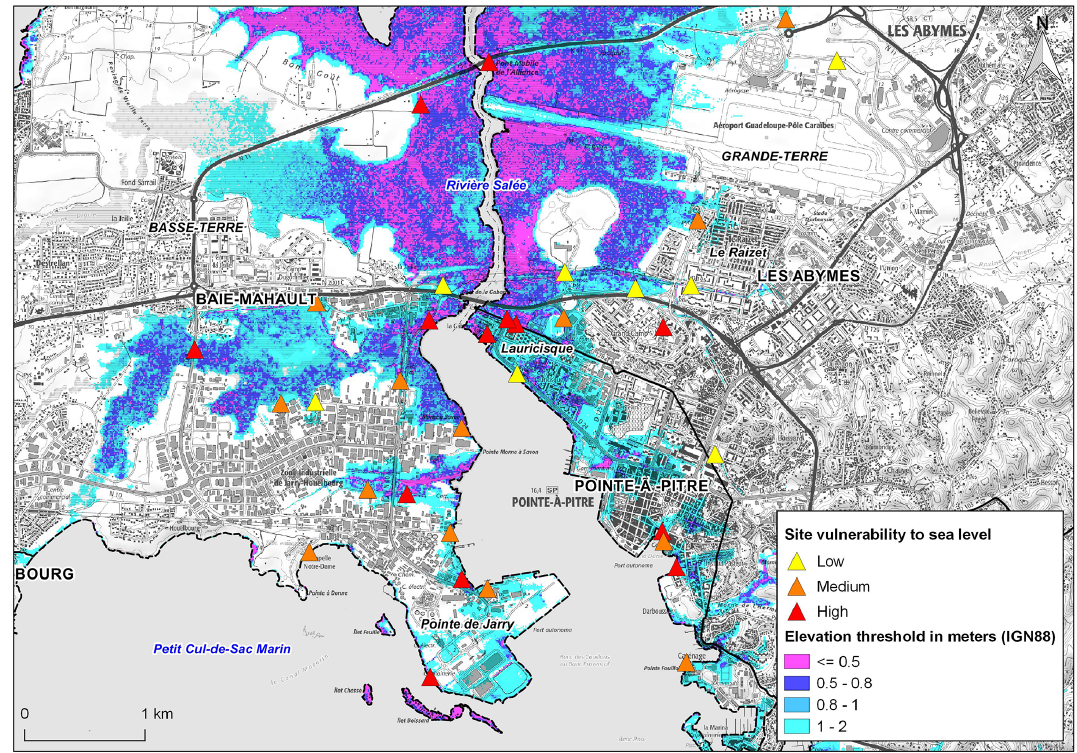
Figure 6. Vulnerable sites identified by Bourdon and Chiozzotto (2012) and their degree of vulnerability and altitude in the Petit Cul-de-sac marin area in Guadeloupe (map created by BRGM; data: IGN, SHOM; © BRGM, IGN, SHOM).